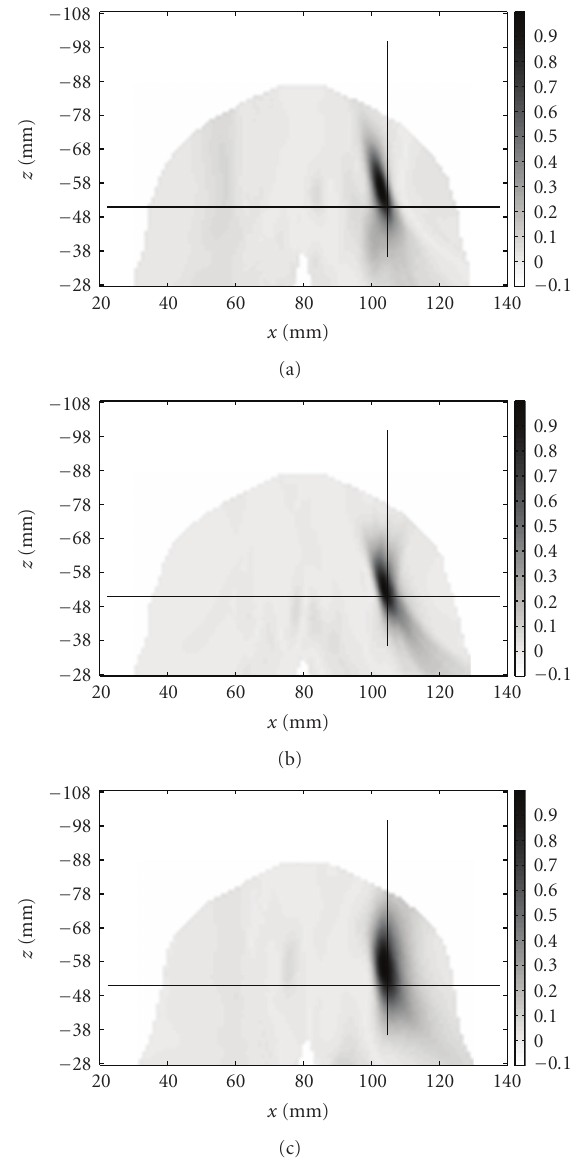
Figure 14: Comparison of focused tumor response between BAVA (a), BAVA-D (b), and TEM horn (c). The intersection of the thin lines shows the center of the inclusion. Each image is normalized to the specific dataset.